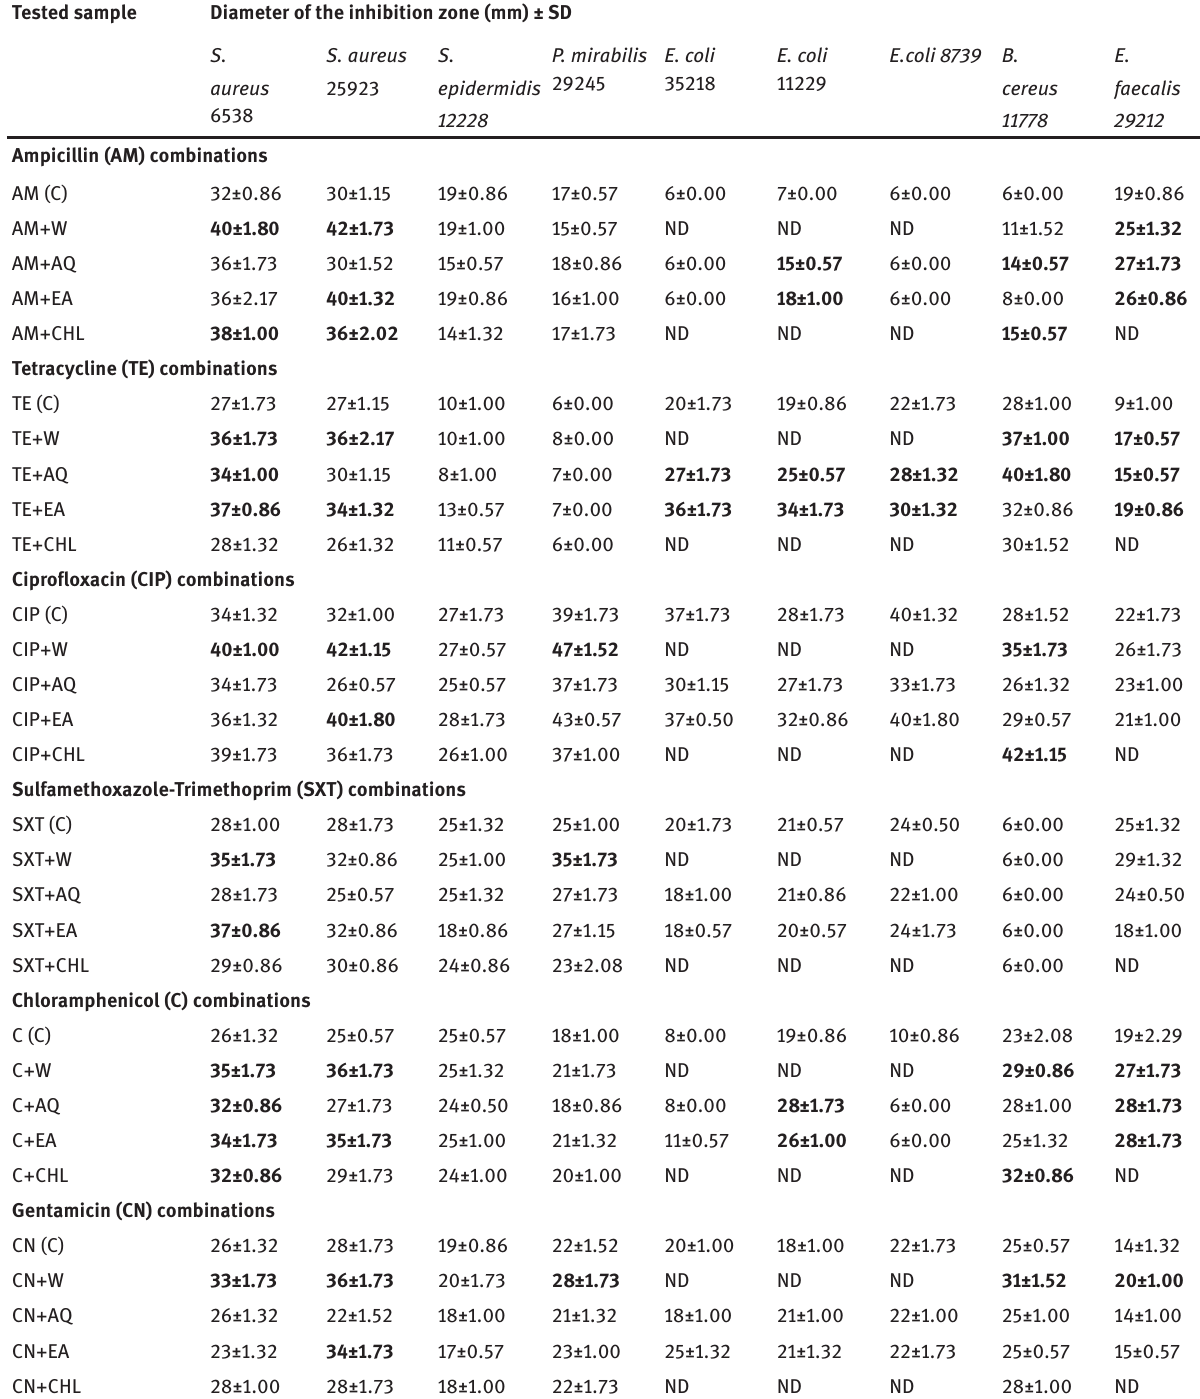
Table 2: The effects of Arctii folium extracts on the antimicrobial activity of the six antibiotics tested on the nine microbial strains, diameter of the inhibition zone (mm) ± SD